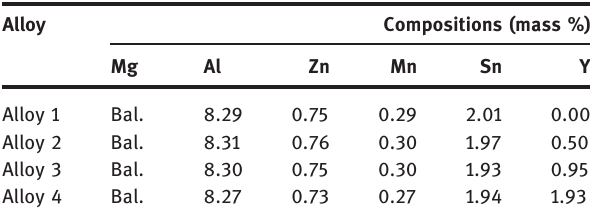
Table 1: The chemical compositions of the studied alloys. Alloy